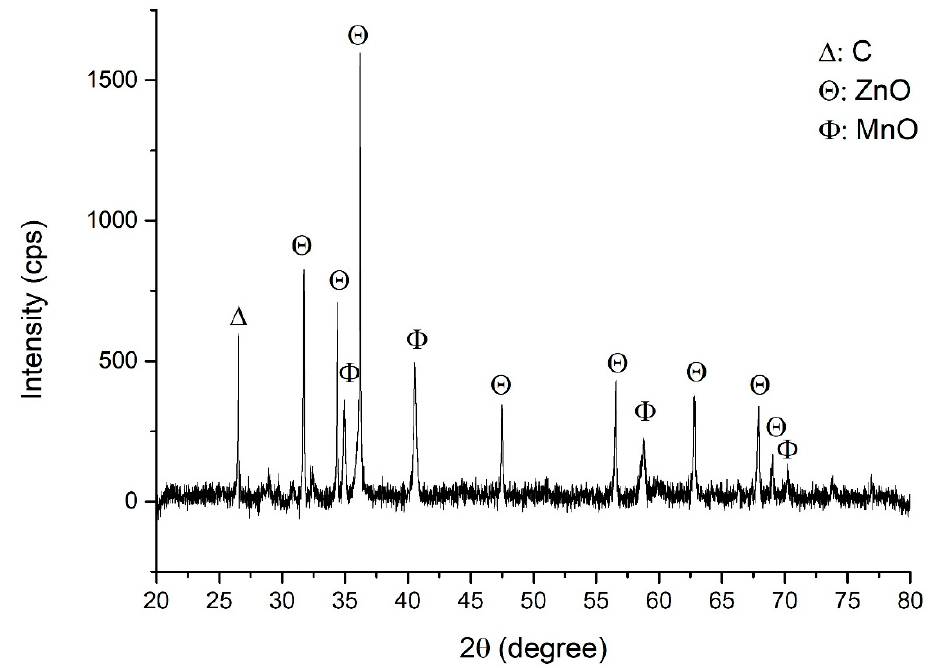
Figure 9. XRD pattern of residue after vacuum applied process with 800 °C and 10 Pa vacuum conditions (lignite as carbon source).